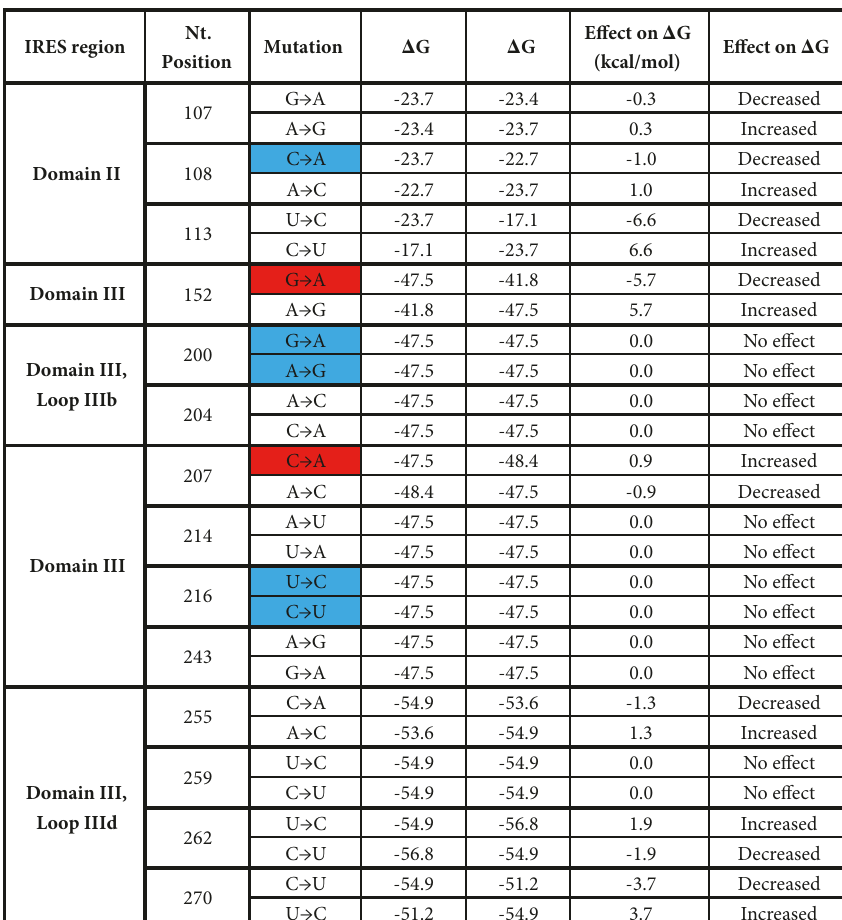
Figure 5: The effect of single point mutations on the thermodynamic stability of the relevant IRES domains. The thermodynamic stability of the relevant domains was calculated using the RNAeval program with RNA free energy parameters and Δ G set at 37 ∘ C. Blue cells indicate mutations detected only in PBMC-derived IRESes while red cells indicate mutations detected only in plasma-derived IRESes.